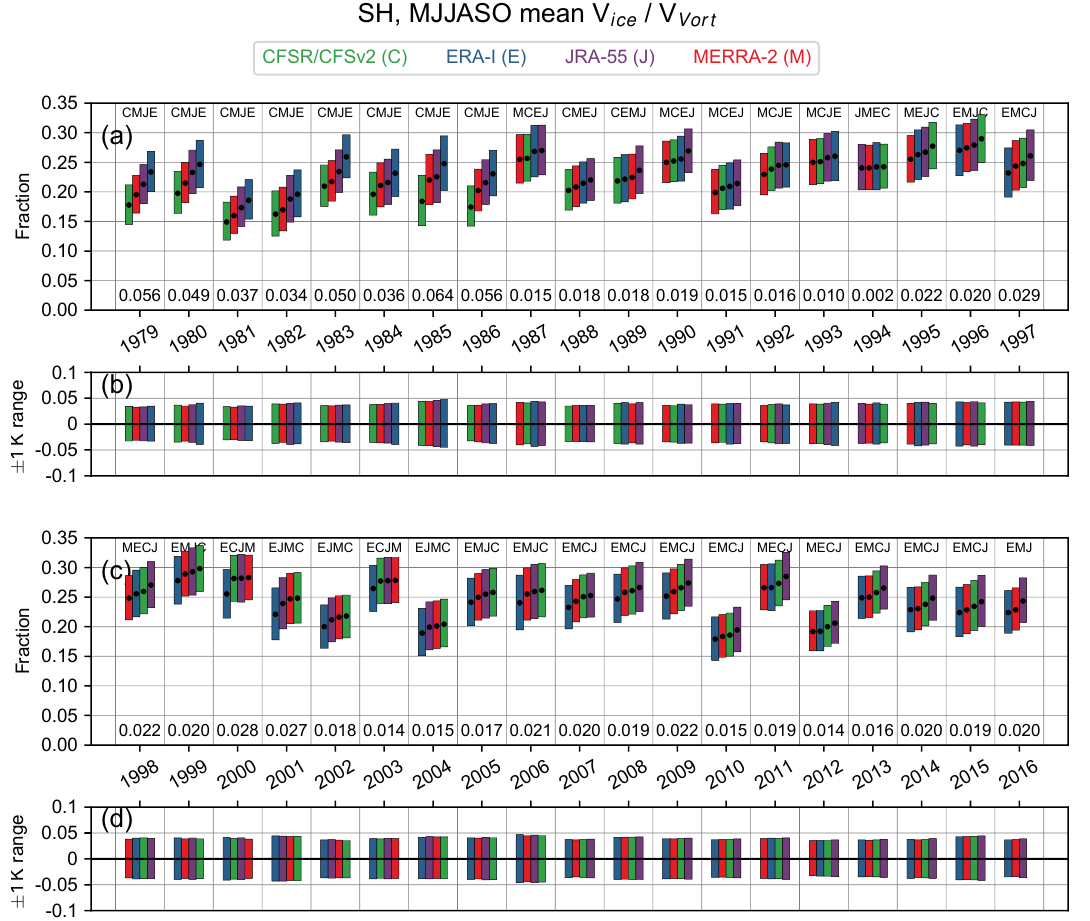
Figure 15. Winter means of the fraction of vortex volume between the 390 and 580K isentropic surfaces with temperatures below T ice in the SH (a, c) , and range of values obtained for the ± 1K sensitivity tests (b, d) . The colored bars show the range of values obtained from the tests of sensitivity to the PSC threshold temperature used (see Sect. 2.2.2), while the black dots show the value for the “central” threshold temperature. The winter mean is calculated over the full MJJASO period. For each year, the reanalyses are ordered from smallest central value on the left to largest central value on the right; this order is also given as a text string at the top of the column for each year. The numbers at the bottom of each year’s column indicate the difference in winter mean fraction between the largest and smallest central values for the winter season (i.e., between the rightmost and leftmost black dots). In the range panels (b, d) , the range about the central value (black dots in a and c ) is shown for each reanalysis. Green, blue, purple, and red indicate CFSR/CFSv2, ERA-I, JRA-55, and MERRA-2,